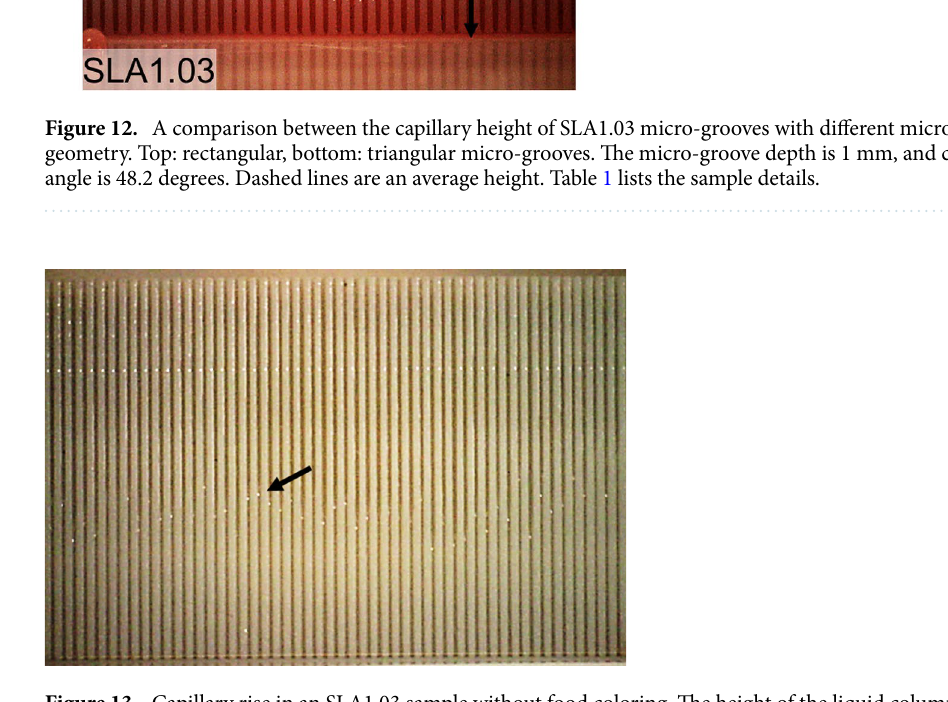
Figure 13. Capillary rise in an SLA1.03 sample without food coloring. The height of the liquid column can be seen as bright spots, by adjusting the light source